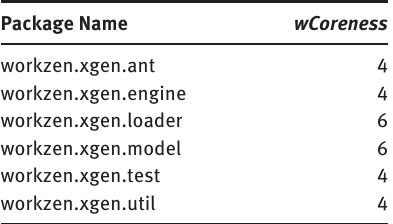
Table 6. wCoreness Values for Packages in xGen.